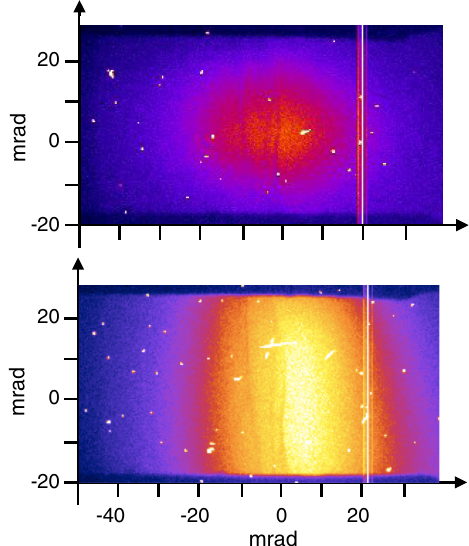
FIG. 4. Measurements of the x-ray beam profiles corresponding to the plasma density profiles displayed in Fig. 2(c). The upper image corresponds to the case without the wire and the lower image to the case with the wire. The images were obtained by imaging a scintillator screen intercepting the x-ray beam (the vertical line is a damage on the camera). The fact that the beam divergence is increased in one direction only demonstrates that the energy γ and the transverse amplitude of oscillation r β of the electrons are both increased thanks to the density gradient produced by the